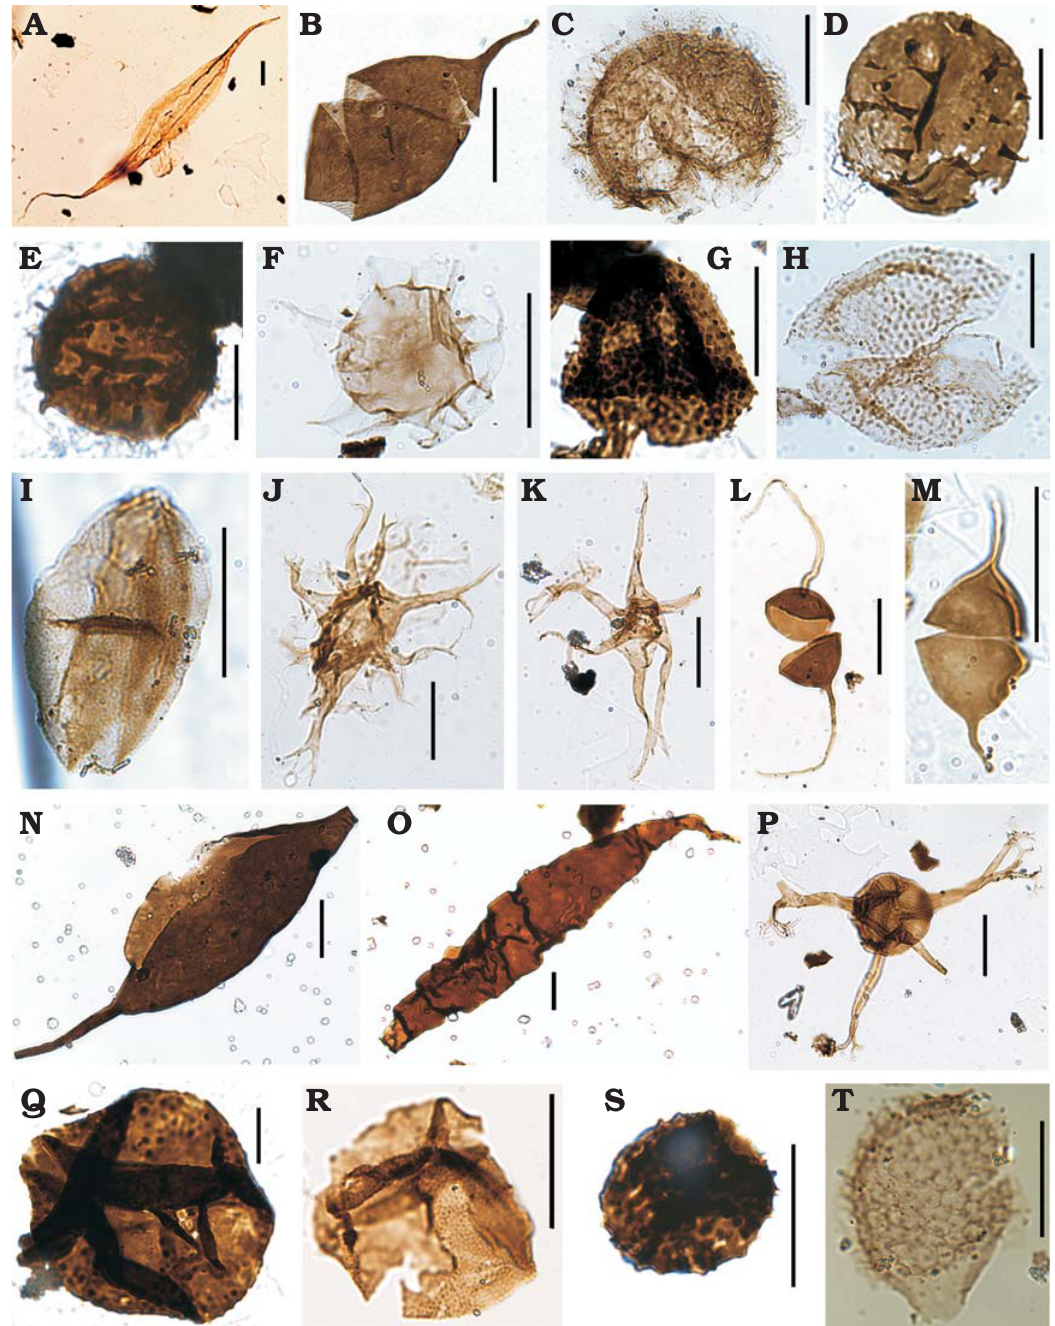
Fig. 8. Palynomorphs from the studied sections of the Los Espejos Formation of Argentina, Cerro La Chilca, Ludfordian (A), Quebrada Ancha, P ř ídolí (B, G, R, T), Quebrada Ancha, Ludfordian (C, E, F, H–L, N–P, S), Quebrada Ancha, Gorstian?–Ludfordian? (D), Cerro La Chilca, Gorstian?–Ludfordian? (M, Q). A . Eupoikilofusa striatifera (Cramer, 1964b) Cramer, 1970; MPLP 4-61059 (H25). B . Eupoikilofusa cantabrica (Cramer, 1964b) Cramer,